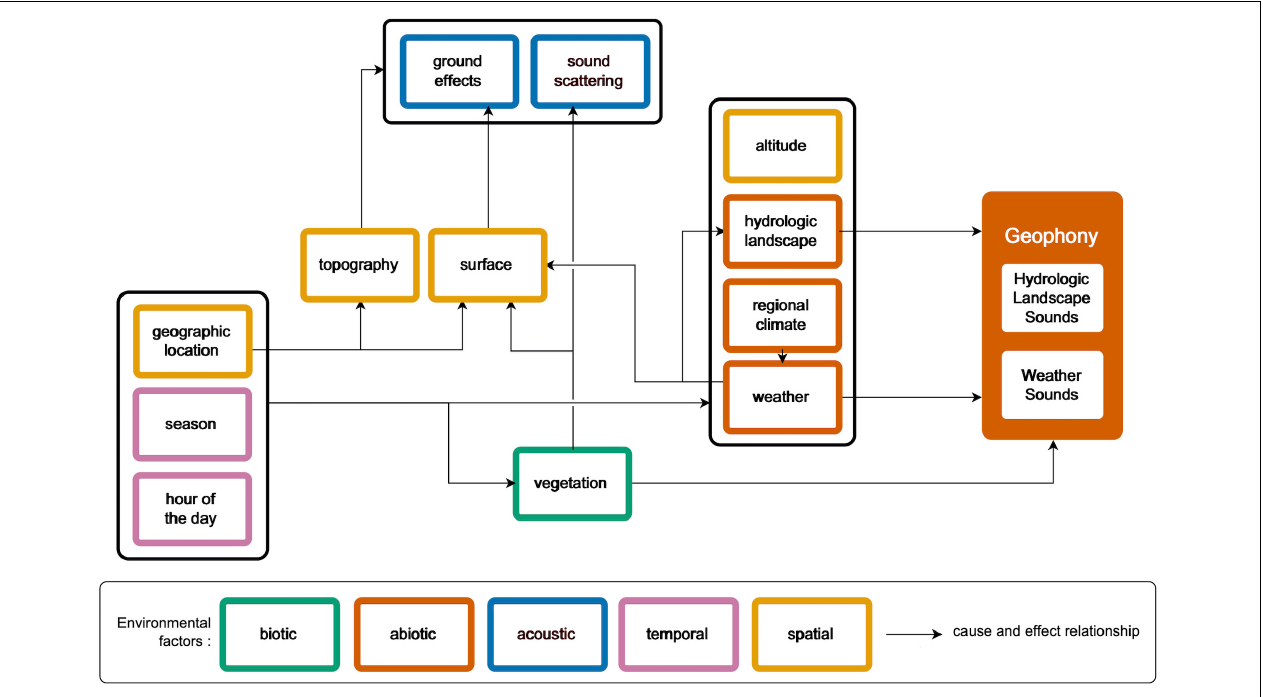
FIGURE 2 | Detailed soundscape functional block diagram: focus on geophony.